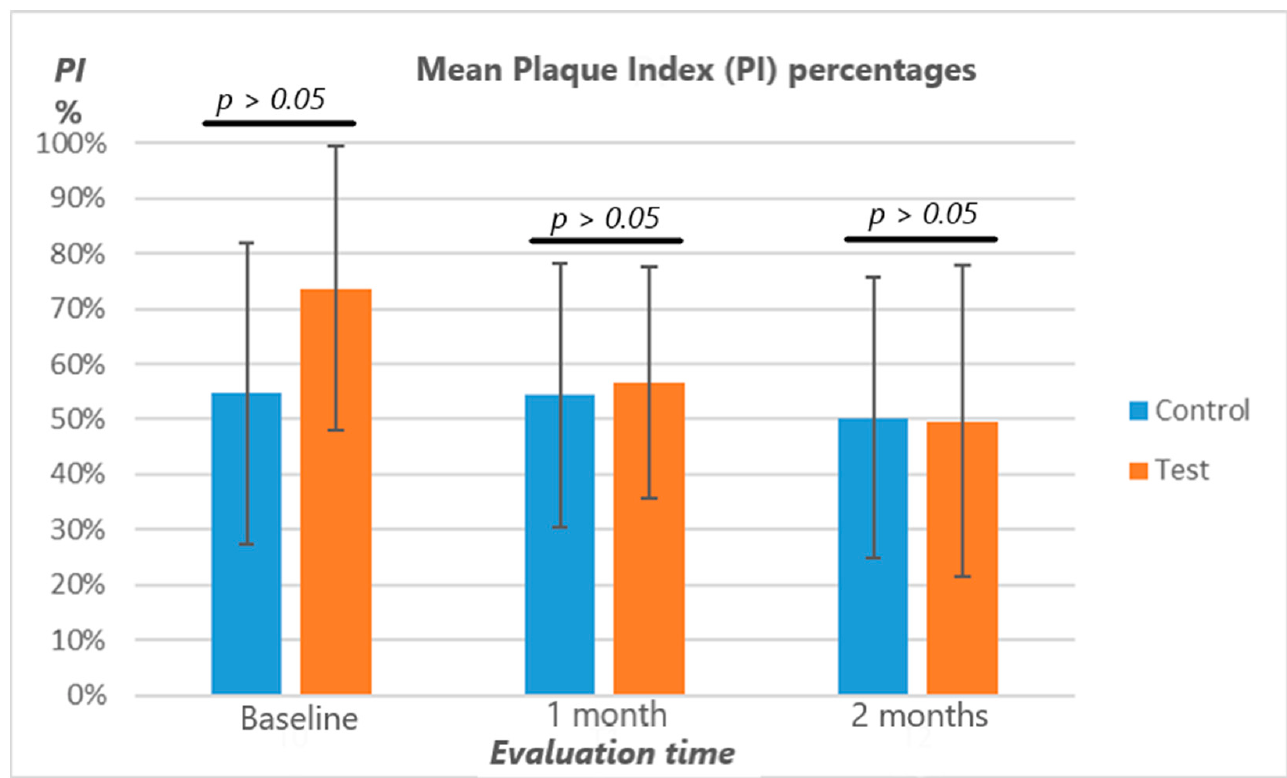
Figure 3. Plaque Index percentages (%): the figure shows the absence of intergroup differences at all the evaluation times ( p > 0.05). As to intragroup differences, a progressive significant reduction in the index was assessed in the trial group (not significant between T1–T2), but not in the control one.